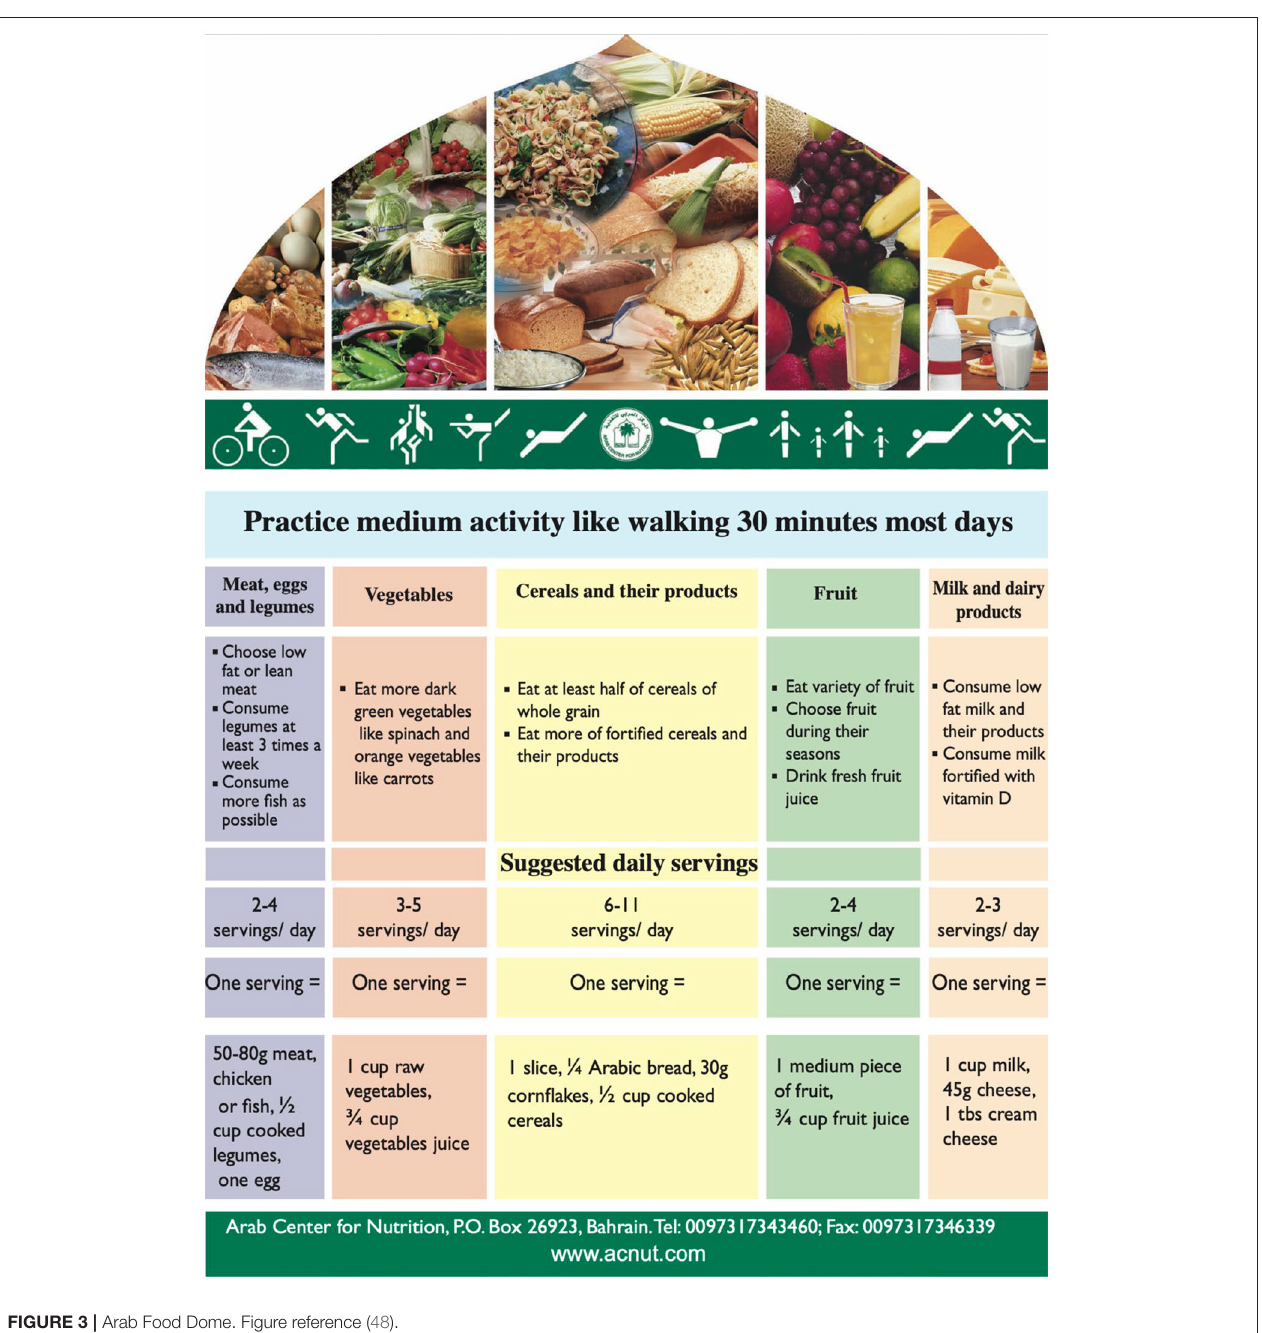
FIGURE 3 | Arab Food Dome. Figure reference